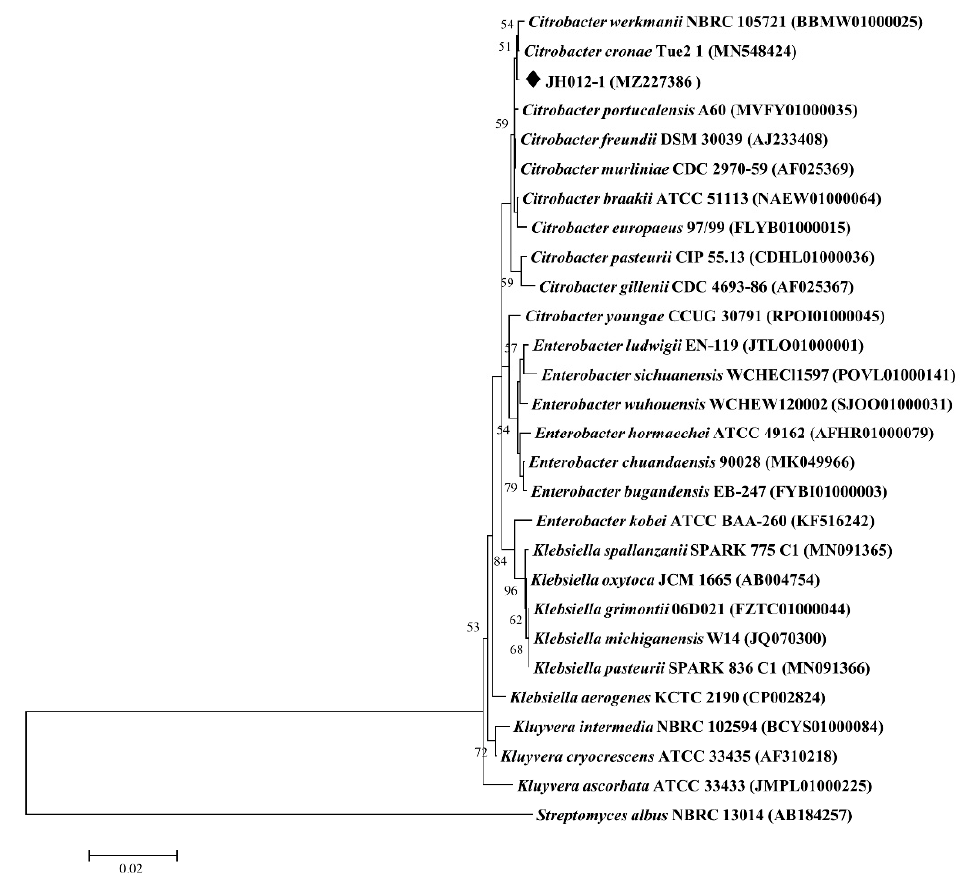
Figure 1. Neighbor-joining phylogenetic tree for the strain JH012-1 based on 16S rRNA sequences. The strain used in this study was marked with black diamond